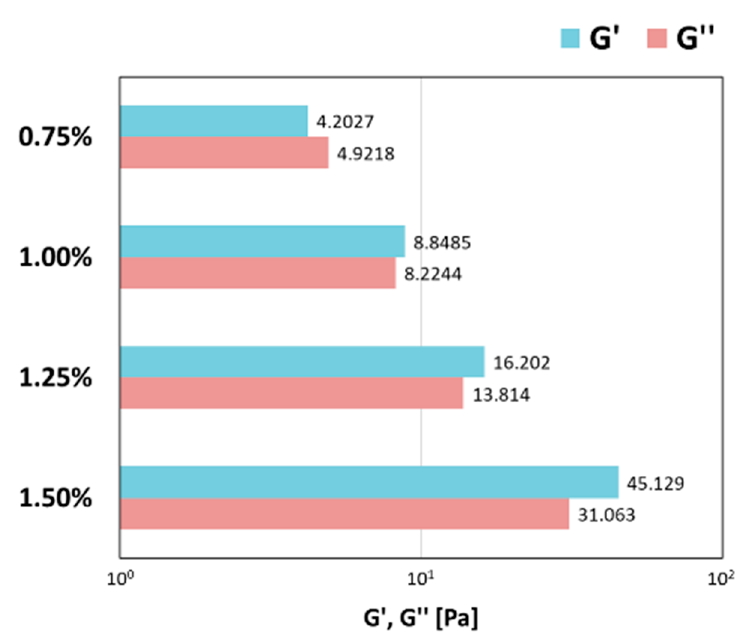
Figure 4. Values of the storage (G ′ ) and loss (G ″ ) moduli measured at a fixed oscillation frequency of 1 Hz for the samples prepared with G–C associations (ratio of 1:3) as a function of the total polymer amount (0.75%, 1%, 1.25%, and 1.5% w/w).